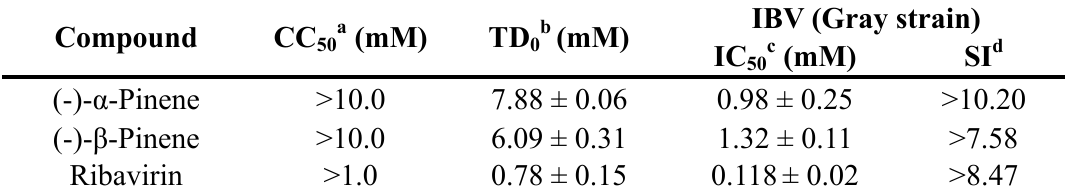
Table 1. Anti-IBV activities of (-)- α -pinene and (-)- β -pinene compared with